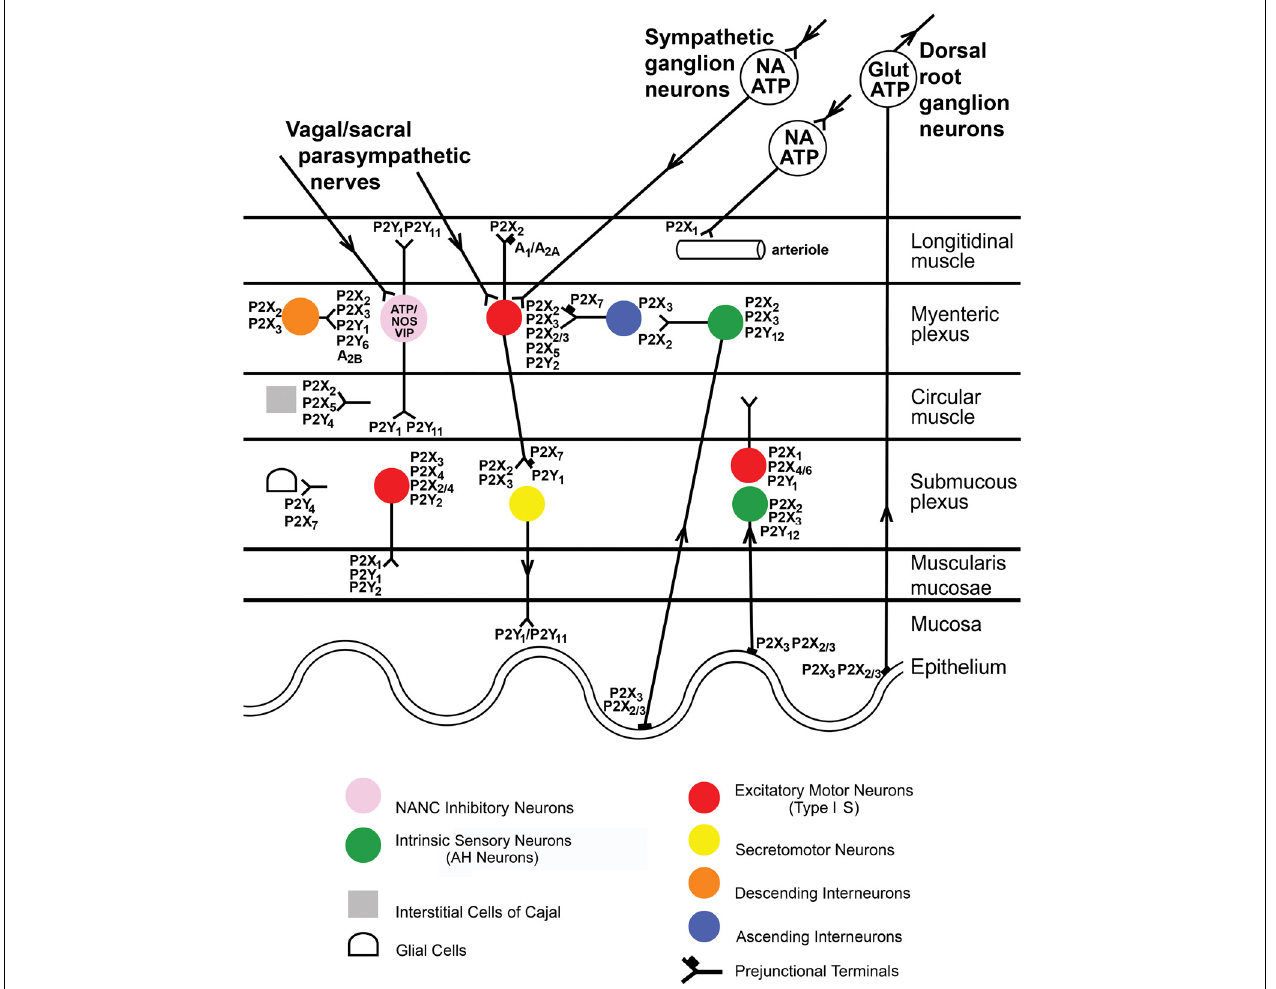
FIGURE 1 | Distribution of P2X receptor subtypes in the gut. Extrinsic vagal and sacral parasympathetic nerves connect with NANC inhibitory neurons in the myenteric plexus expressing P2X2 and P2X3 receptors, as well as with cholinergic motor neurons; these neurons are also activated by descending interneurons. Extrinsic sympathetic nerves modulate motility via excitatory motor neurons and constrict blood vessels in the gut via P2X1 receptors. Extrinsic sensory nerves arise from cell bodies in dorsal root ganglia and with subepithelial terminals expressing P2X3 and P2X2/3 receptors and mediate nociception.